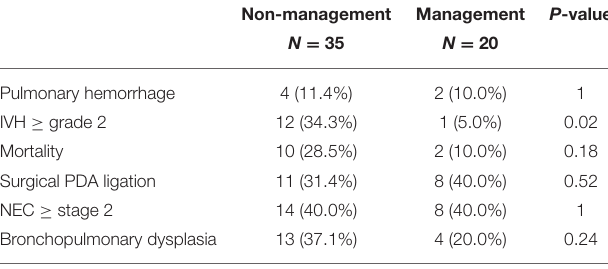
TABLE 1 | Demographic data in the non-management and management groups. TABLE 2 | Outcomes in the non-management and management